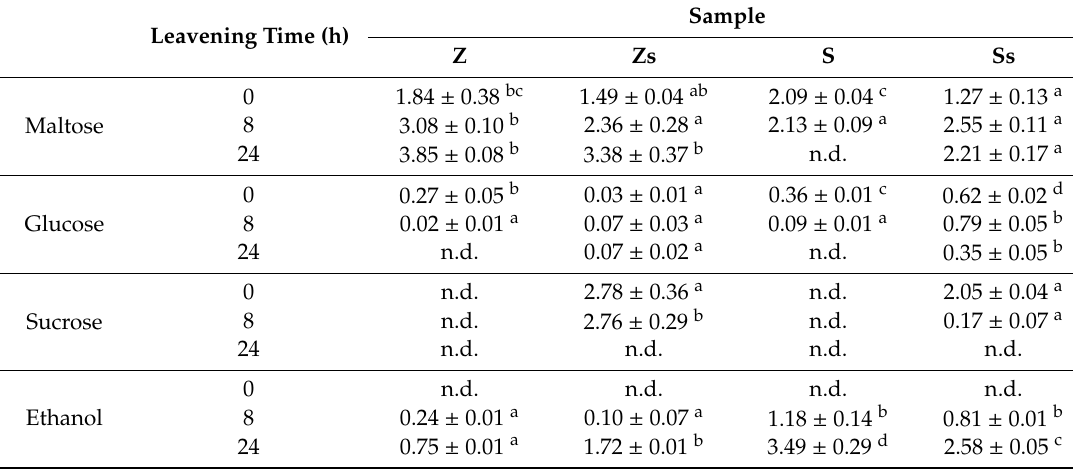
Table 2. Maltose, glucose, sucrose, and ethanol concentrations (g/100 g flour; mean ± standard deviation values of two technological replicates) in doughs leavened at 26 °C by Z. mobilis (Z) or S. cerevisiae (S), without and with sucrose (s) addition (2.5 g/100 g flour) at 0, 8, and 24 h of leavening. See Table 1 for sample identifications and formulations.